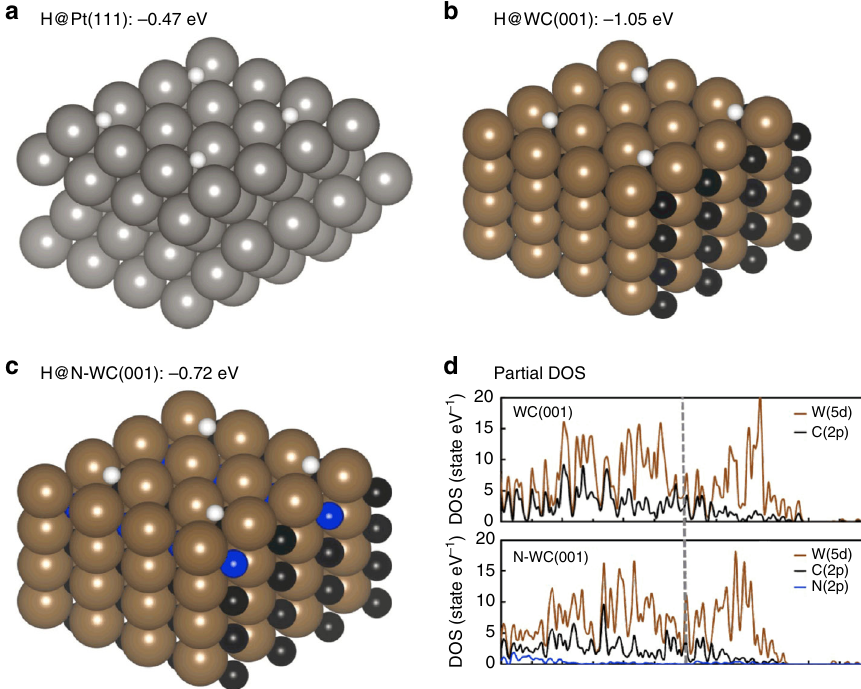
Fig. 1 DFT hydrogen binding geometries and binding energies. Hydrogen binding geometries and binding energies of a WC (001) surface, b N-WC (001) surface, c Pt (111) surface, and d calculated partial density of state (DOS) of WC (001) and N-WC (001). The vertical dash line denotes the position of the Fermi level. Color key: black, brown, white, blue, and gray balls represent C, W, H, N, and Pt atoms,